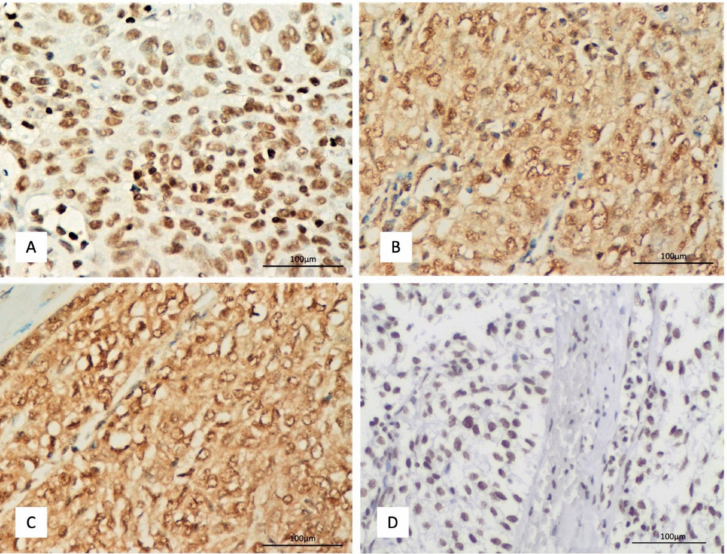
Figure 1. Immunohistochemical expression of ( A ) DAXX in a A type thymoma ( B ) CENP-A in a B3